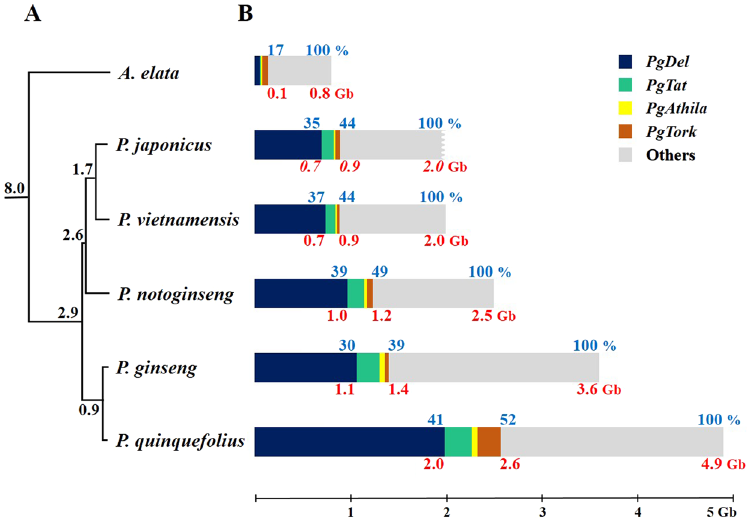
Figure 4. Comparison between proportions of four major repeats in five Panax species and A . elata . ( A) Phylogenetic relationships based on chloroplast sequences modified from Kim et al. 25 . Estimated time since divergence (MYA) is indicated at the root of branch divisions. (B) The predicted genome size of Panax species and A . elata are depicted as bar charts with the estimated amounts of PgDel , PgTat , PgAthila , and PgTork families contained in each genome represented by blue, green, yellow, and brown regions, respectively. Genome contents not containing these repeats are represented by the grey region. Blue letters above bars indicate GP of PgDel alone (left), GP of four LTR-RT families (middle), and total GP of the genome (right). Red letters below bars indicate estimated amount in Gb of PgDel contents alone (left), contents of four LTR-RT families (middle), and total genome size (right). For A . elata , blue letters above bars indicate GP of four LTR-RT families (left) and total GP of the genome (right), whereas red letters below bars indicate estimated amount in Gb of four LTR-RT families (left) and total genome size (right). Total genome size of P . japonicus was estimated in the present